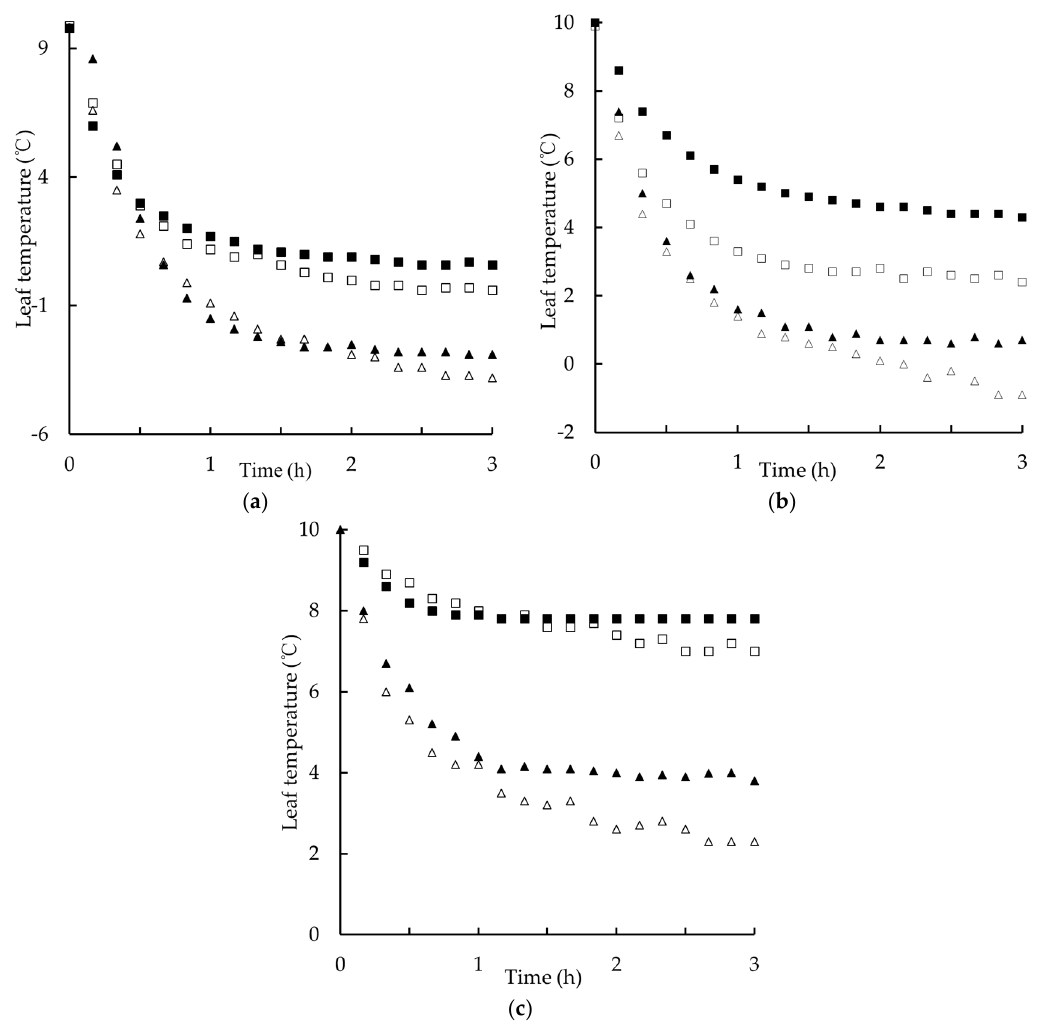
Figure 8. T basic was set to − 5.0 °C ( a ); 0 °C ( b ); and, 5.0 °C ( c ) while the T radiation was set to − 40 °C ( △ ), − 20 °C ( ▲ ), 0° C ( □ ), and control ( ■ ), respectively.